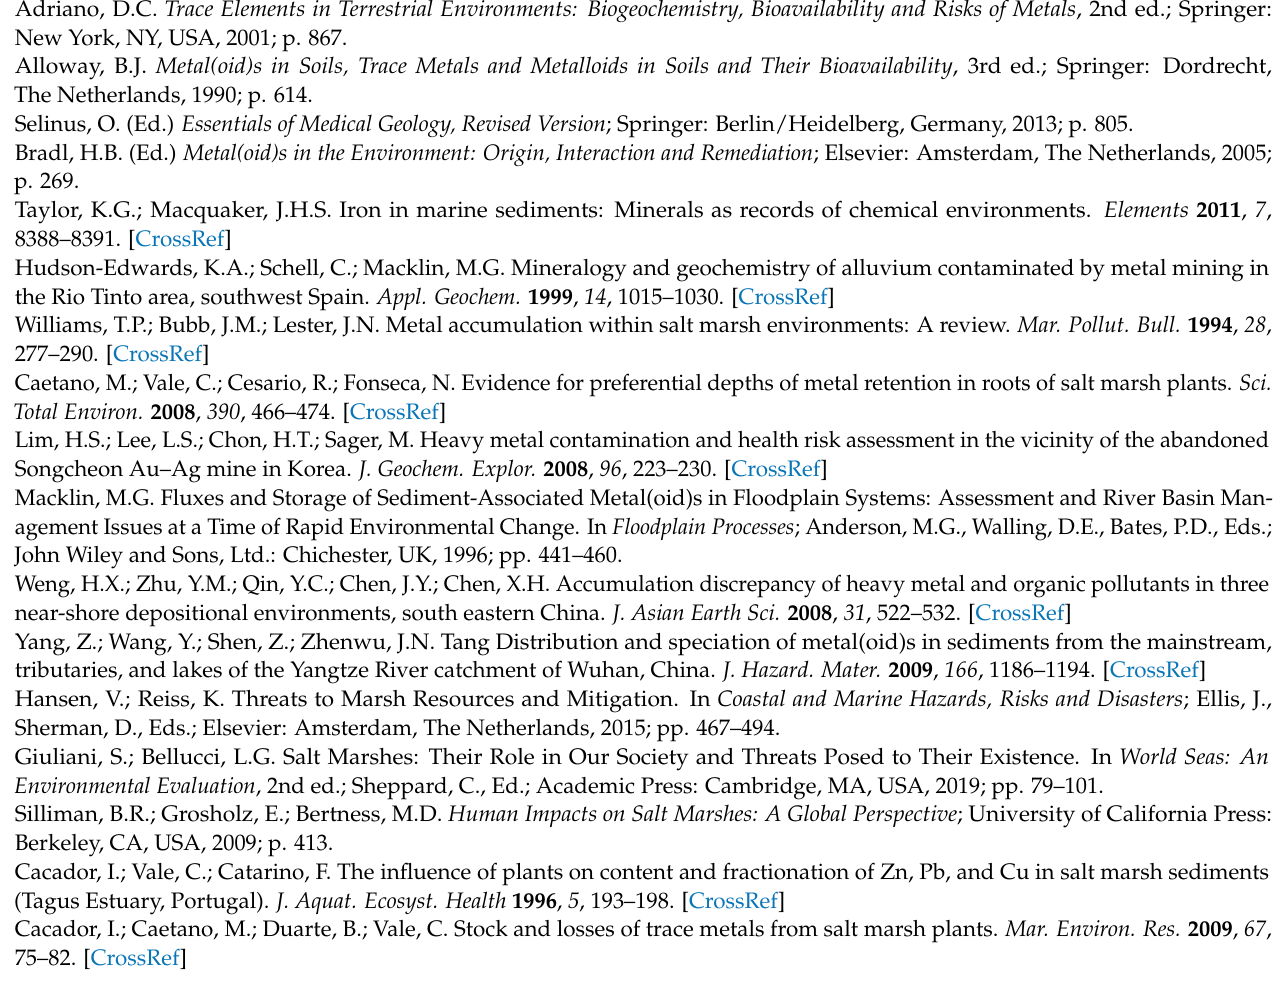
pH, major elements and metal(oid)s. Table S1: Quality Control report. Table S2: Enrichment factor (EF) values caluculated for all samples. Table S3: Granulometric parameters. Table S4: TOC and pH